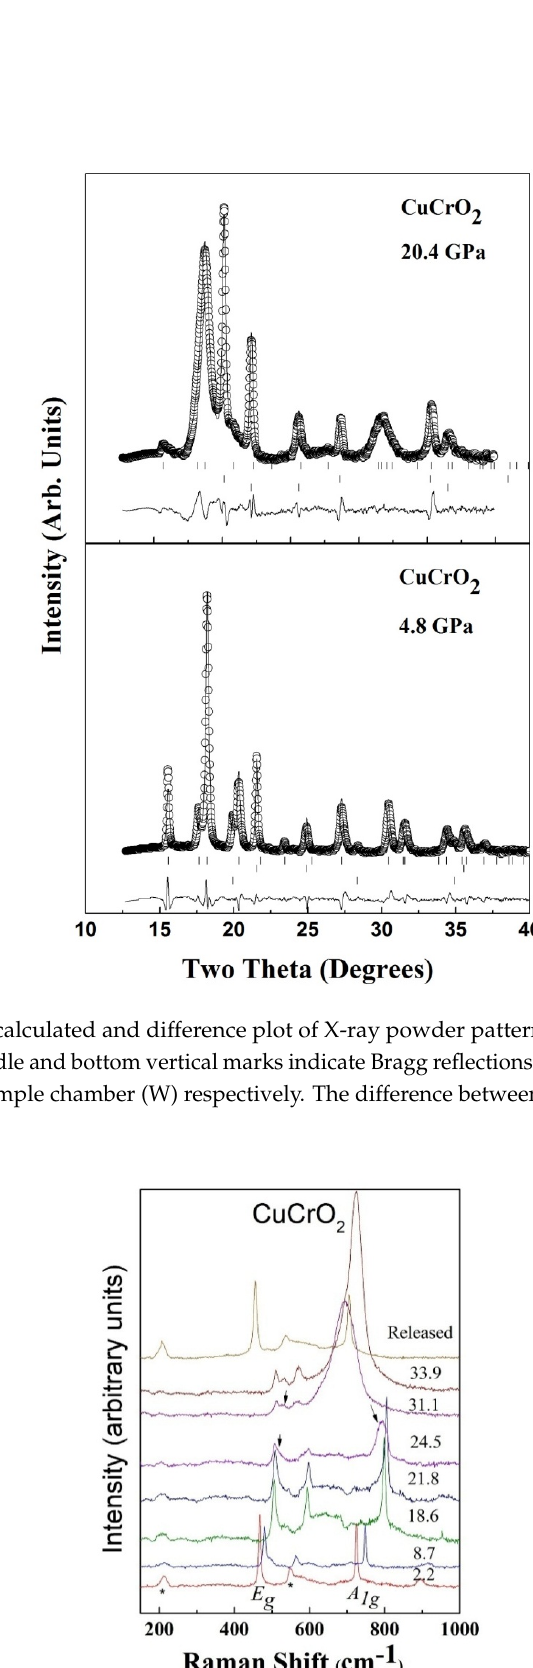
Figure 9. Pressure evolution of Raman spectra of CuCrO 2 at a few selected pressures. Arrow indicates the splitting of E g mode and appearance of new modes at higher frequency which soften with pressure.